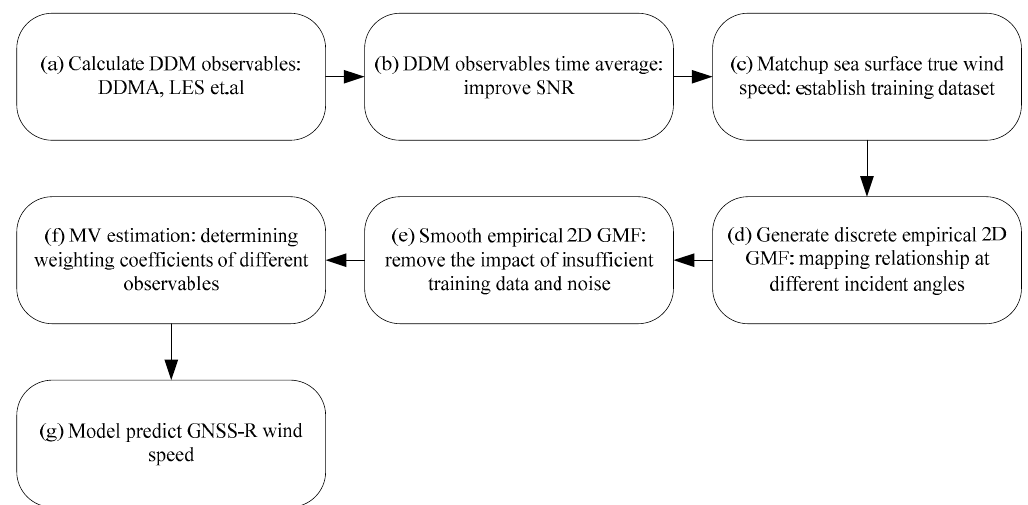
Figure 1. Flow chart of spaceborne GNSS-R wind speed retrieval